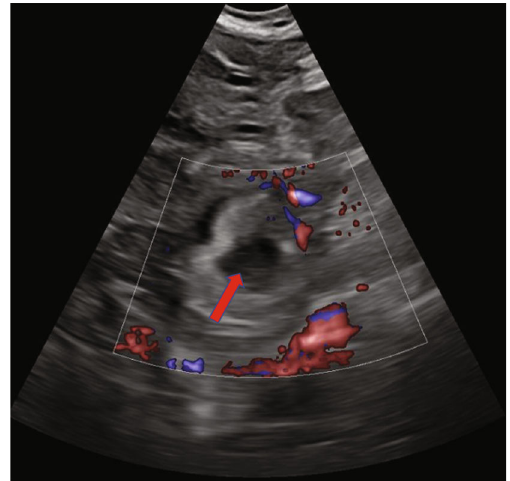
Figure 2: Longitudinal transvaginal ultrasound of the right adnexa demonstrates a thick walled hypoechoic cystic structure (red arrow) with weak peripheral vascularity ( “ ring of fi re ” ). There is no fetal pole present.